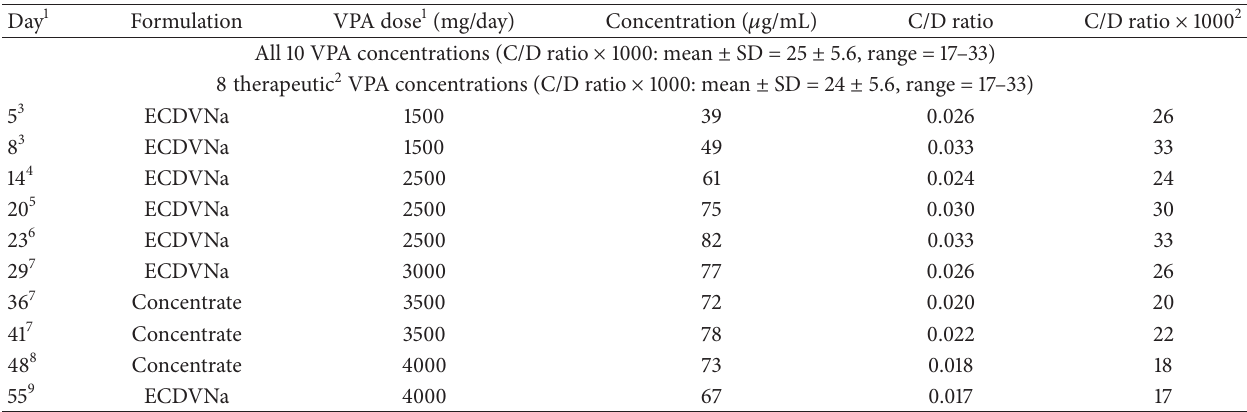
Table 3: VPA C/D ratio in Case